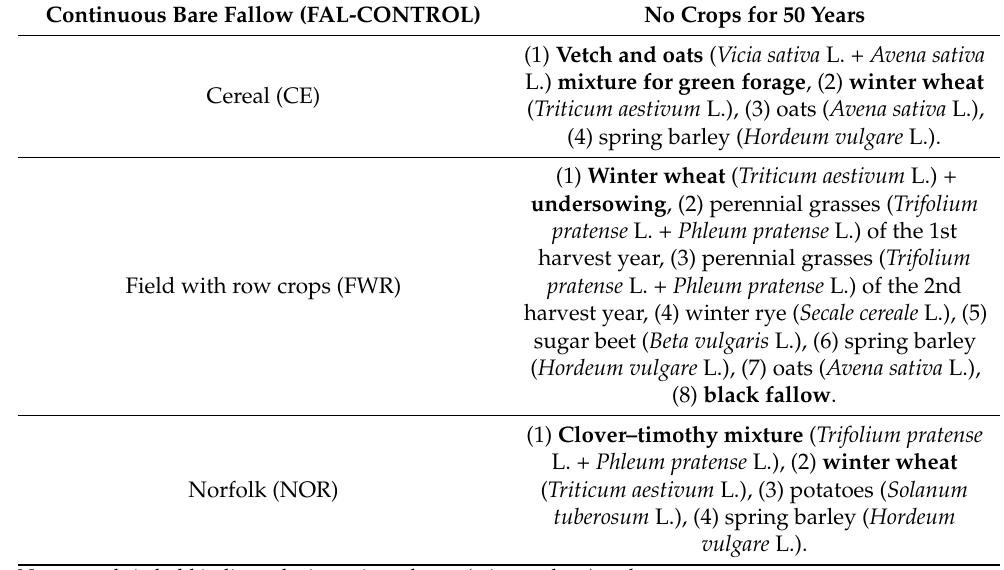
Table 2. Sequence of crop rotations.